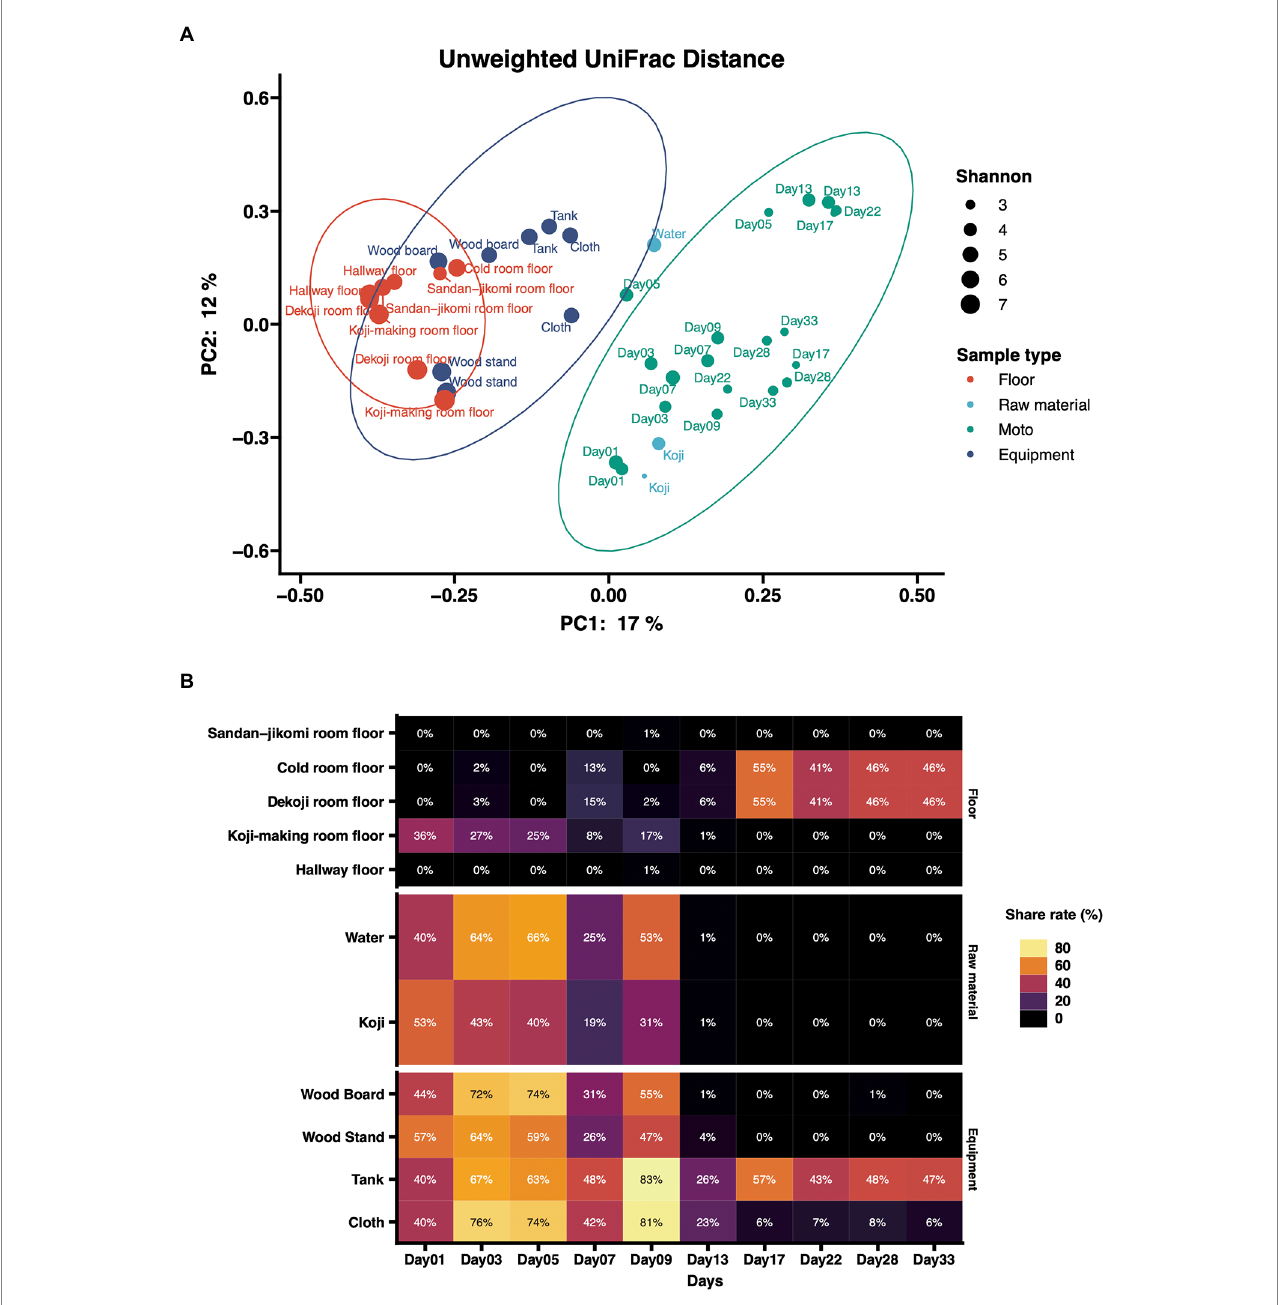
FIGURE 4 (A) Principal-coordinate analysis (PCoA) by Weighted UniFrac distance of environmental samples and Moto samples. The dot size shows the values of Shannon diversity of each sample. (B) Time-series changes in the relative abundance of shared ASVs in Moto during the Kimoto -style fermentation period. More than 40% of the microbiomes in Moto on Day 33 shared the ASVs with the tank surface, cold room floor, and Koji -making room floor